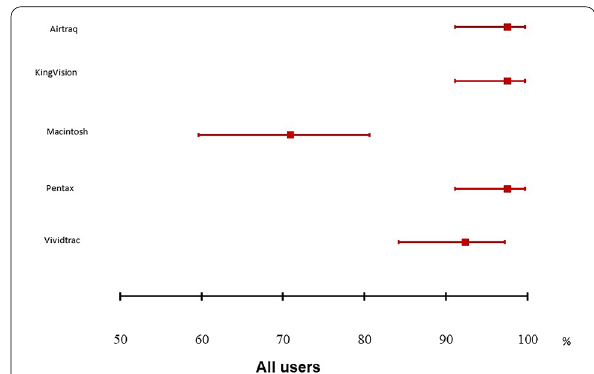
Fig. 2 Forest plot of the first‑pass success rate with each videolaryngoscope included in the MACMAN2